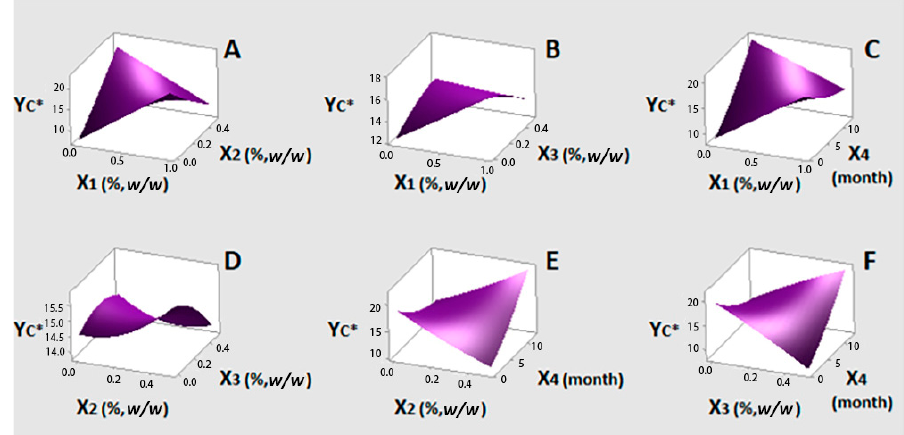
Figure 3. A-F three-dimensional surface plots for color parameter C* (Y C* ) as a function of oregano (X 1 %, w/w ), lemon balm (X 2 %, w/w ), bay laurel (X 3 %, w/w ) EOs contents and time (X 4 , month). In all cases, the rest factors were kept constant at their middle levels (0.5%, 0.25% and 0.25% w/w and seven months, respectively).